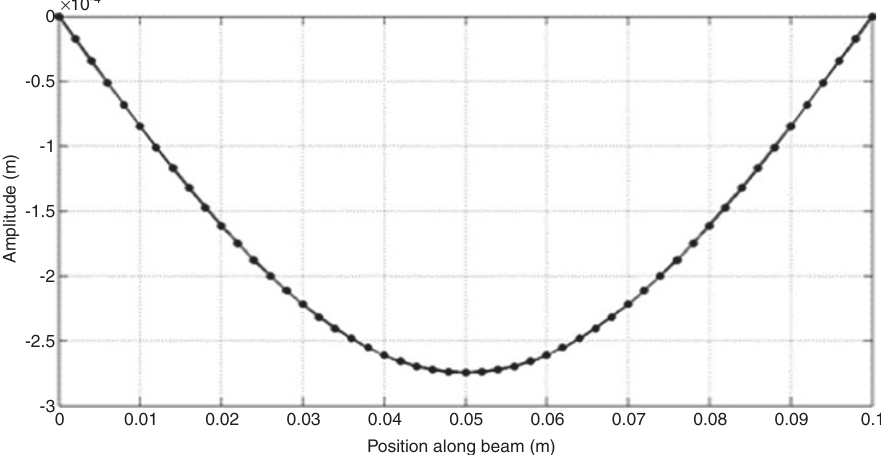
Figure 17: Vibrations of the first characteristic mode of the simply supported